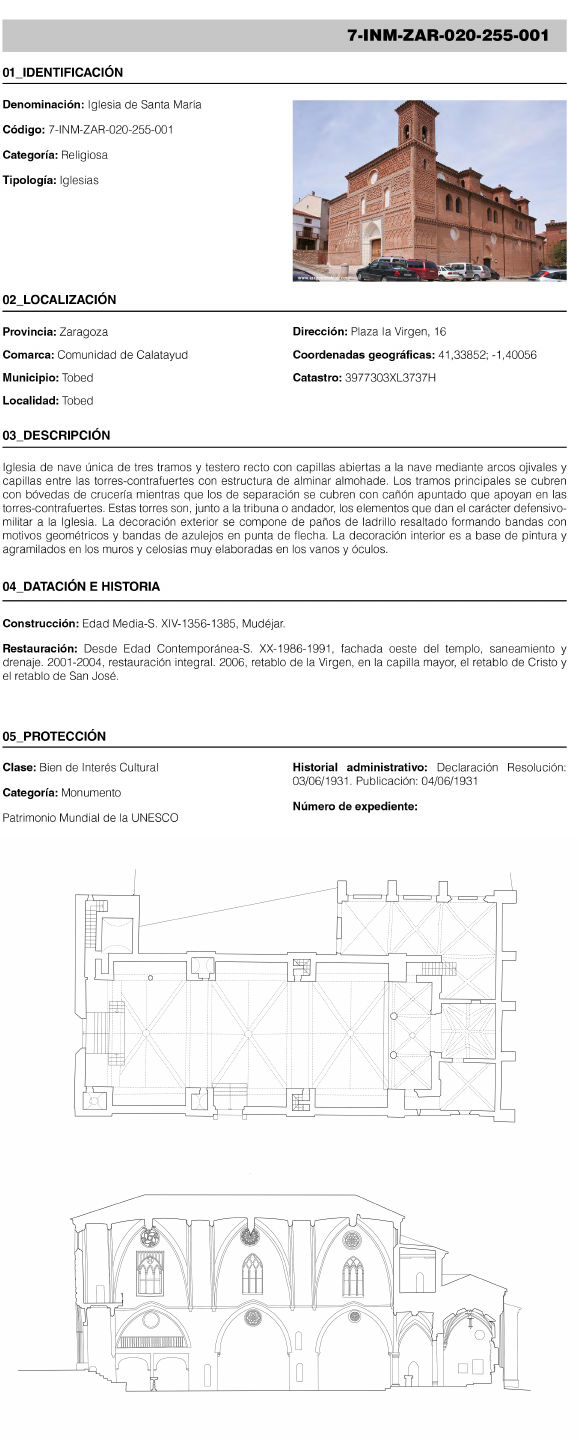
Figure 2. Digital sheet containing descriptive and graphical information for the Santa Mar´ıa church (Tobed,